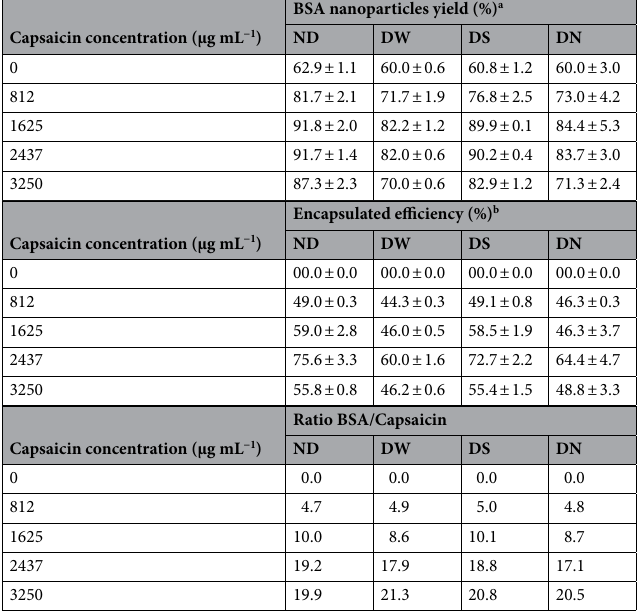
Table 1. Nanoparticle yield, entrapment efficiency and ratio BSA/Capsaicin. a,b n = 3 ± SD.